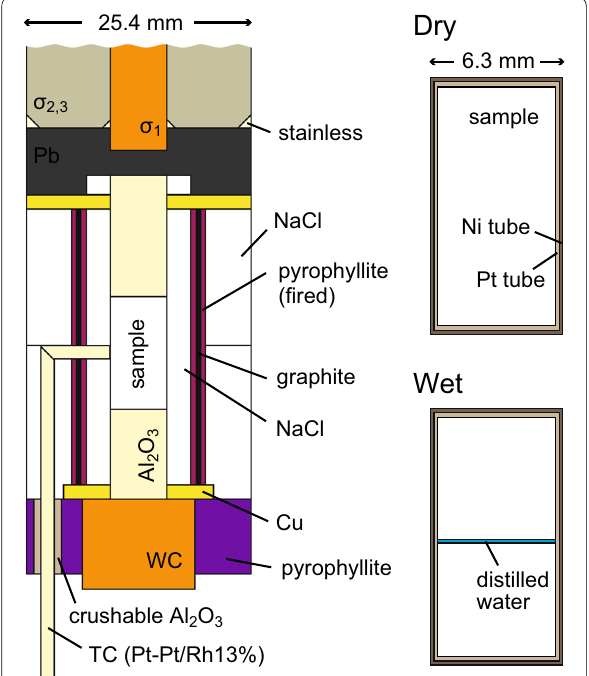
Fig. 2 Schematic diagrams of the whole sample assembly (left) and enlarged inner sample assemblies (right) for the dry and water‑added experiments. The water added between the two columns surrounds these columns during the high‑pressure and high‑temperature experimental